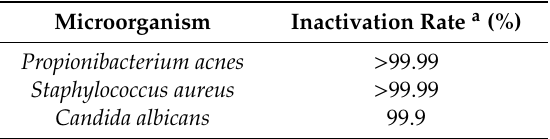
Table 3. Antimicrobial activity of Sapindus mukorossi seed oil extract.